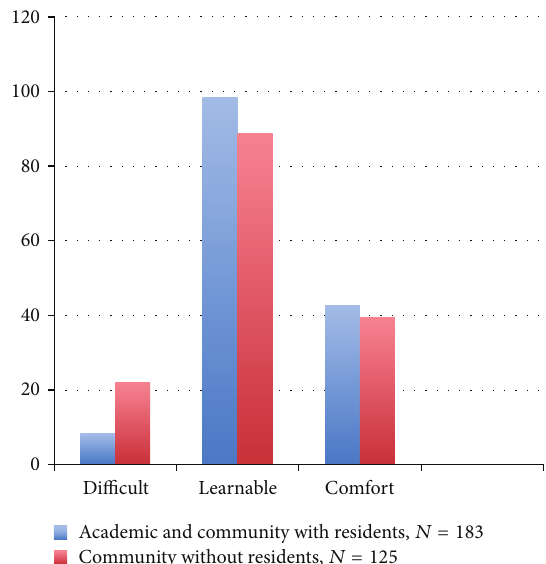
Figure 3: Percent agreement comparison of all surgeons with residents versus community surgeons without